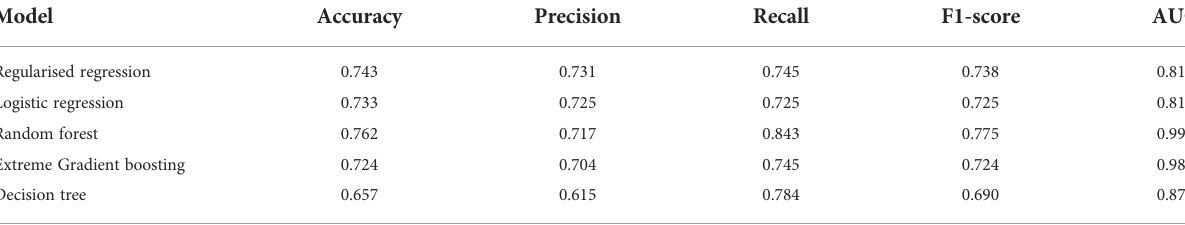
TABLE 1 Performance measure of classi fi er machine learning